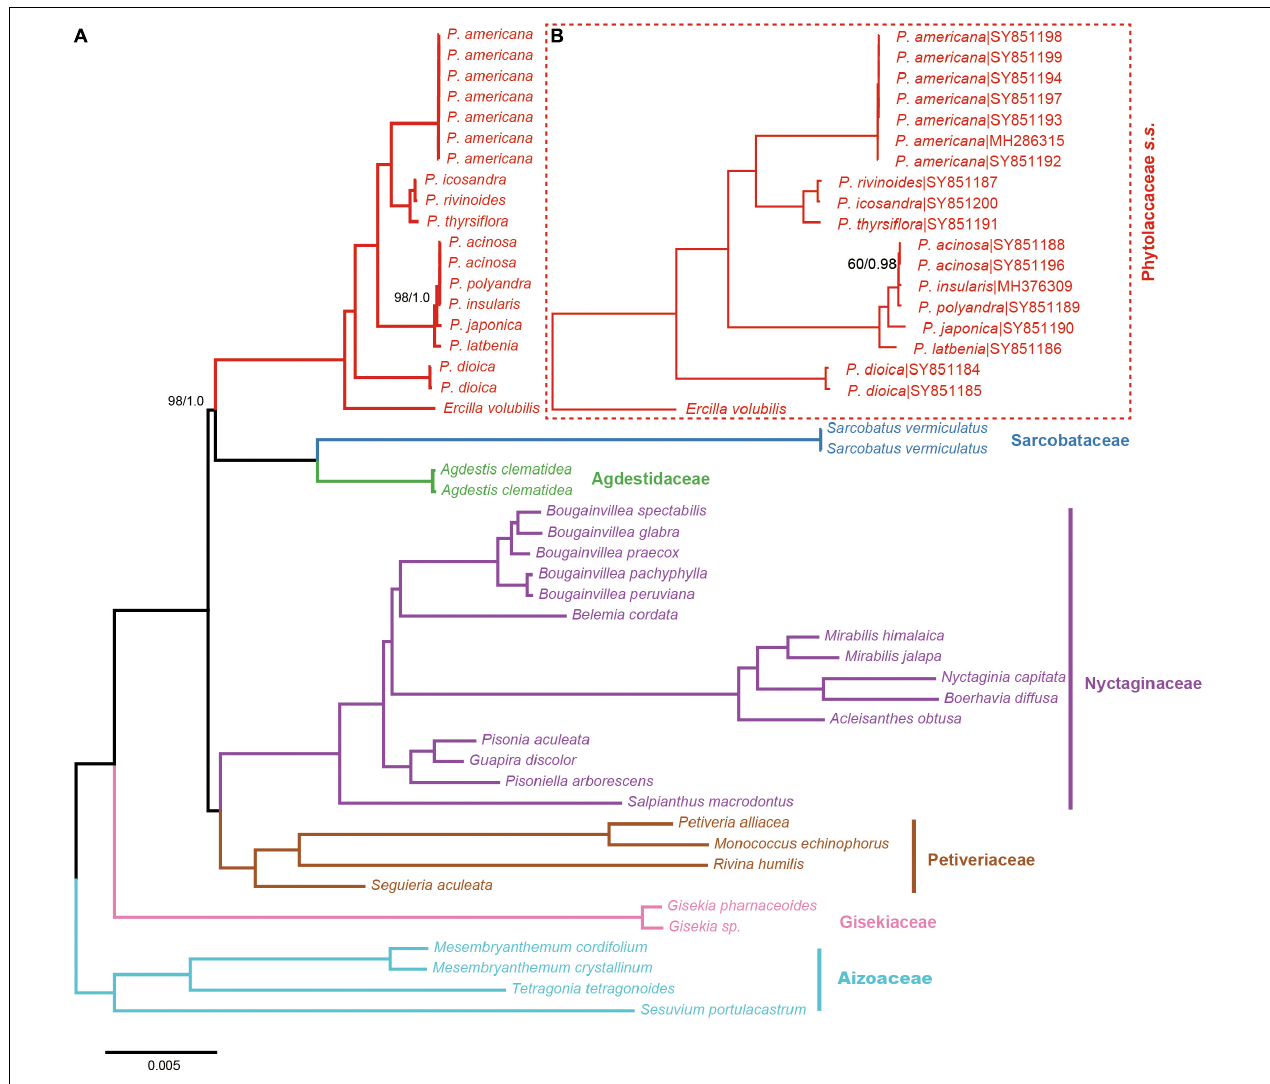
FIGURE 1 | Phylogenetic trees of Phytolaccaceae s.l. and its allies obtained from an ML and BI analysis of the complete chloroplast genome. (A) ML tree with a strict hierarchical clustering partitioning scheme using the 83g48s dataset. (B) ML tree with GTR + G model using the 19cpg dataset. ML bootstrap support value/Bayesian posterior probability presented at each node. Node support values of ML = 100/BI = 1.0 were not